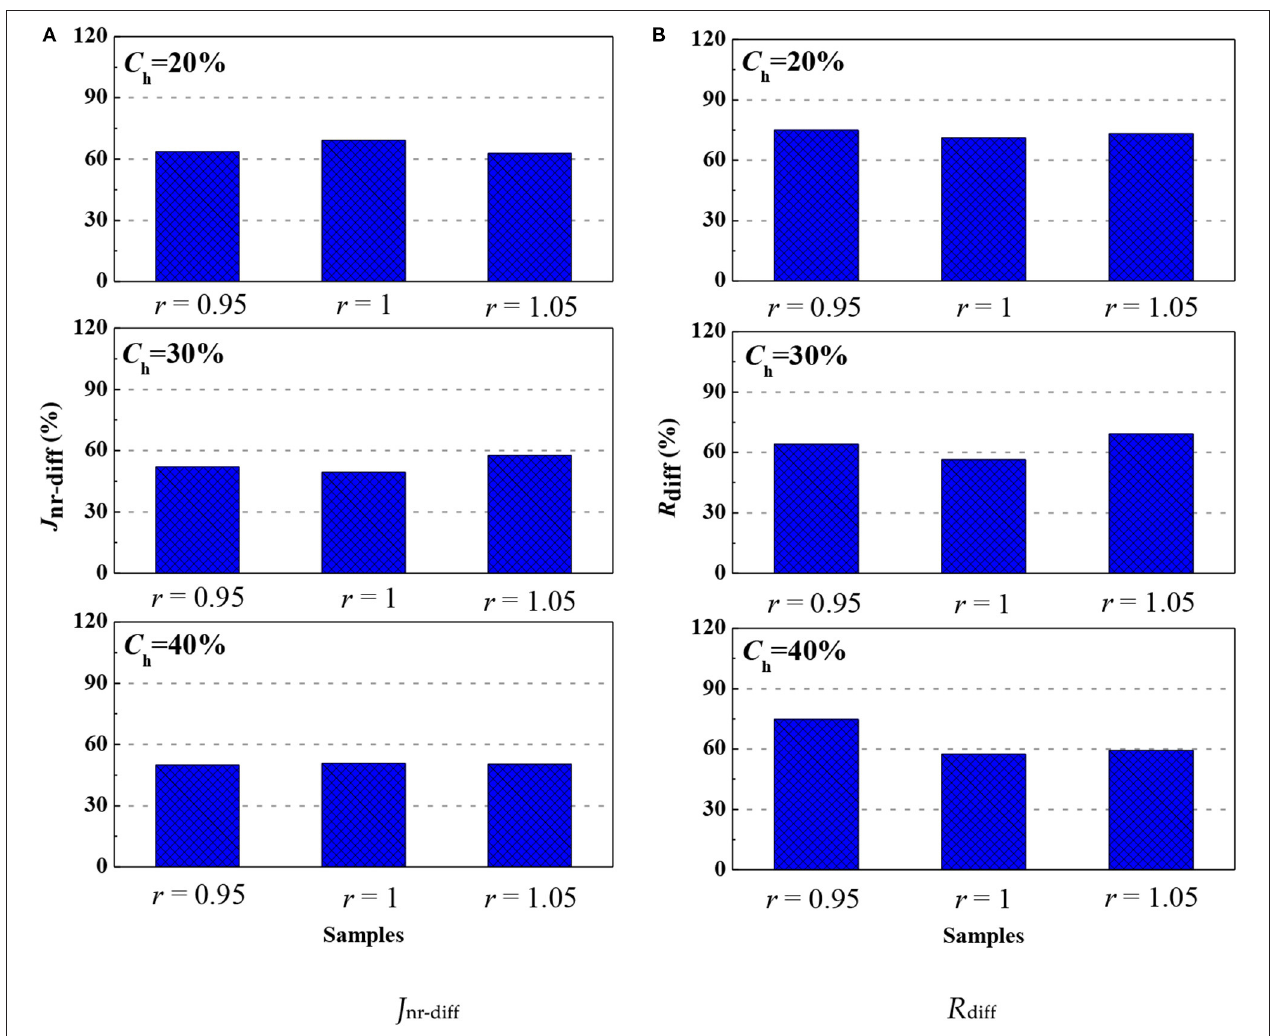
FIGURE 35 | Change the rules of stress sensitivity (Polyether-based TPU). (A) J nr − diff . (B) R diff